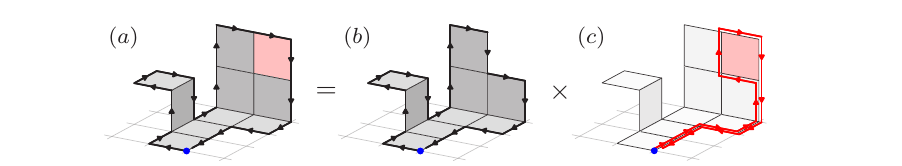
Figure 1. An arbitrary contractible Wilson loop on the lattice consisting of n squares (a) can be decom- posed into a product of a loop with n 1 squares missing one plaquette (b) and a parallel transported − single plaquette (c). Figure from